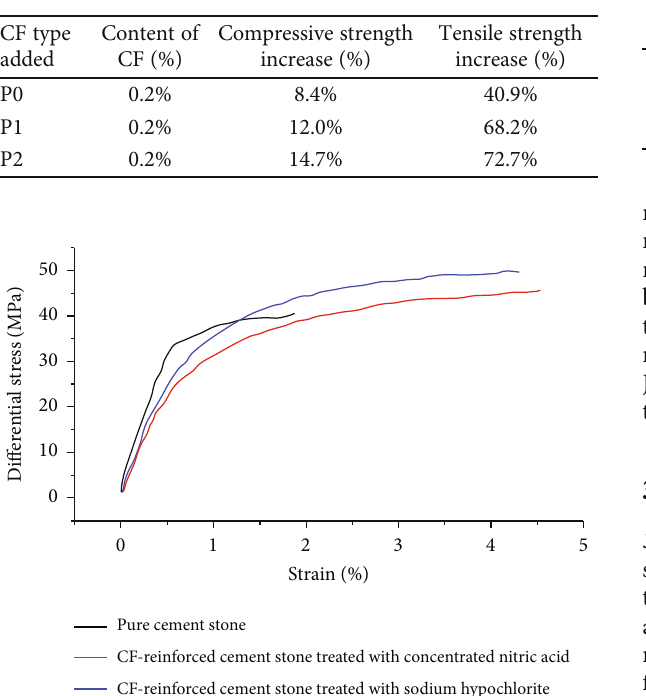
Figure 3: Compressive strength and tensile strength of cement stone. Table 7: Mistrial testing results for cement Table 6: Comparison of mechanical strength between carbon fi ber- reinforced cement stone and pure cement stone.